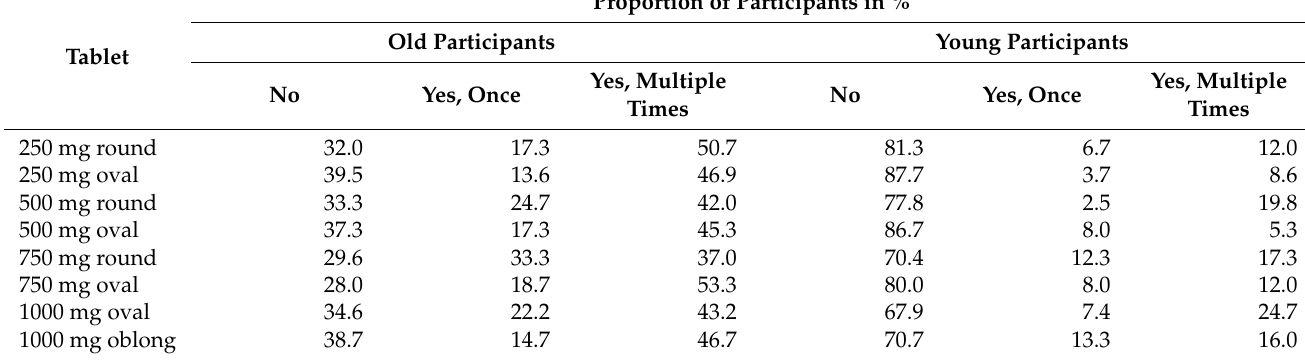
Table 3. Repeated water intake after the cup of water has been removed from the mouth for the first time. Data are shown separately for the two age categories and include three observations per study participant for each tablet.